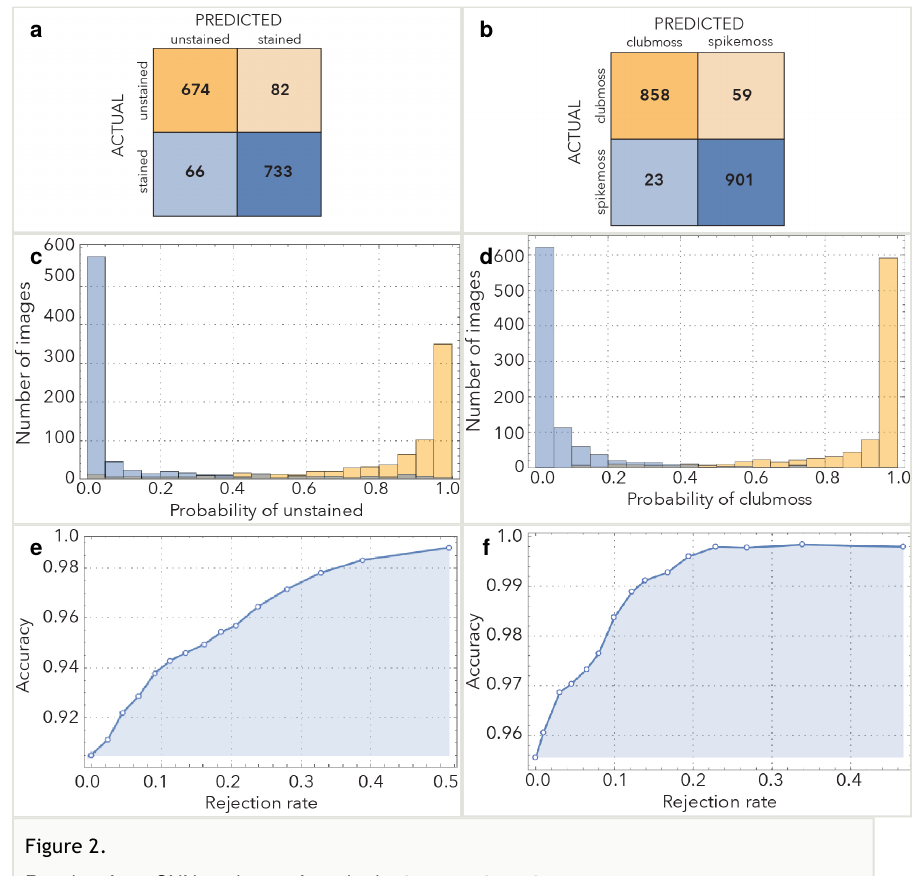
Results of our CNN analyses of test herbarium specimen